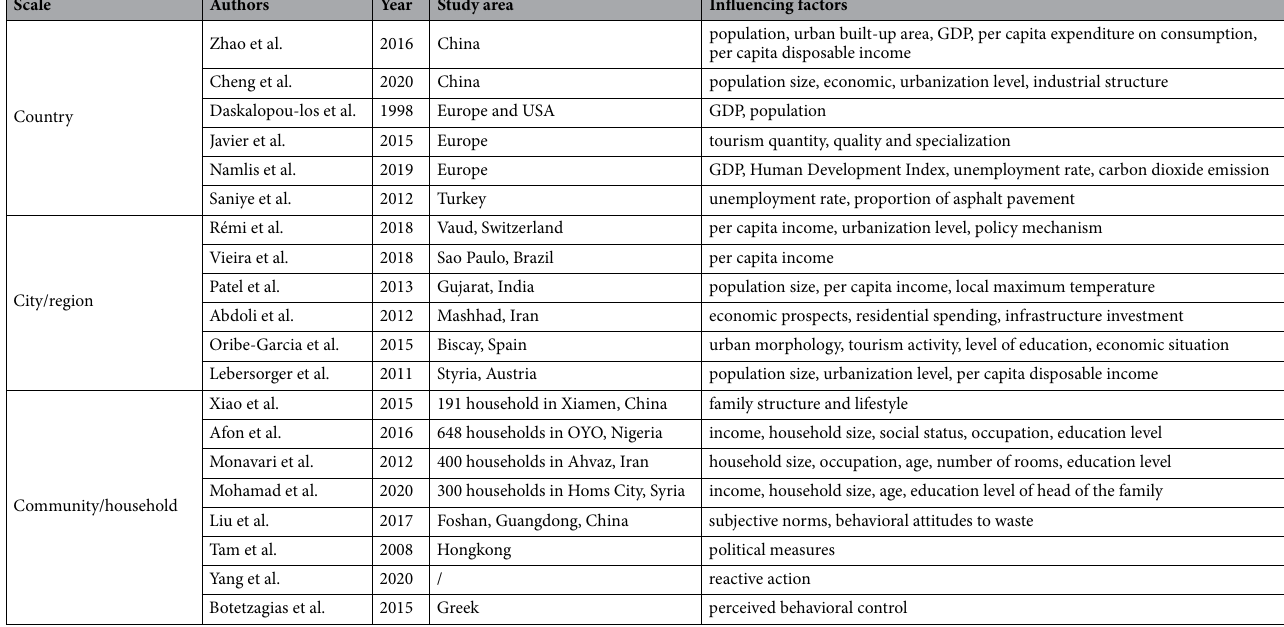
Table 1. Recent studies on the influencing factors of